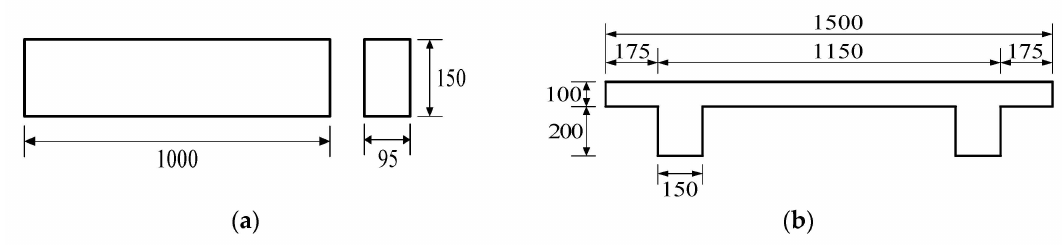
Figure 1. Two types of test beam specimens: ( a ) Dimension of rectangular concrete beam ( b ) Cross-sectional dimension of double-T beam (dimensions in mm).